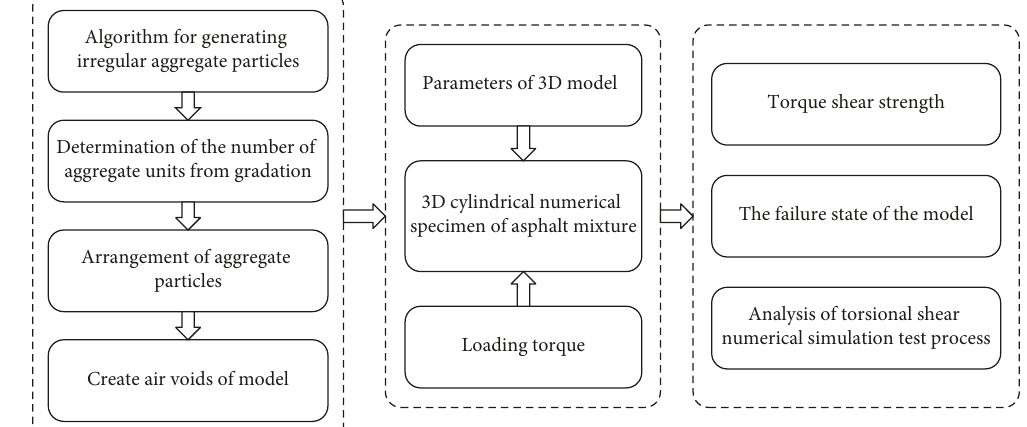
Figure 1: The flowchart of the